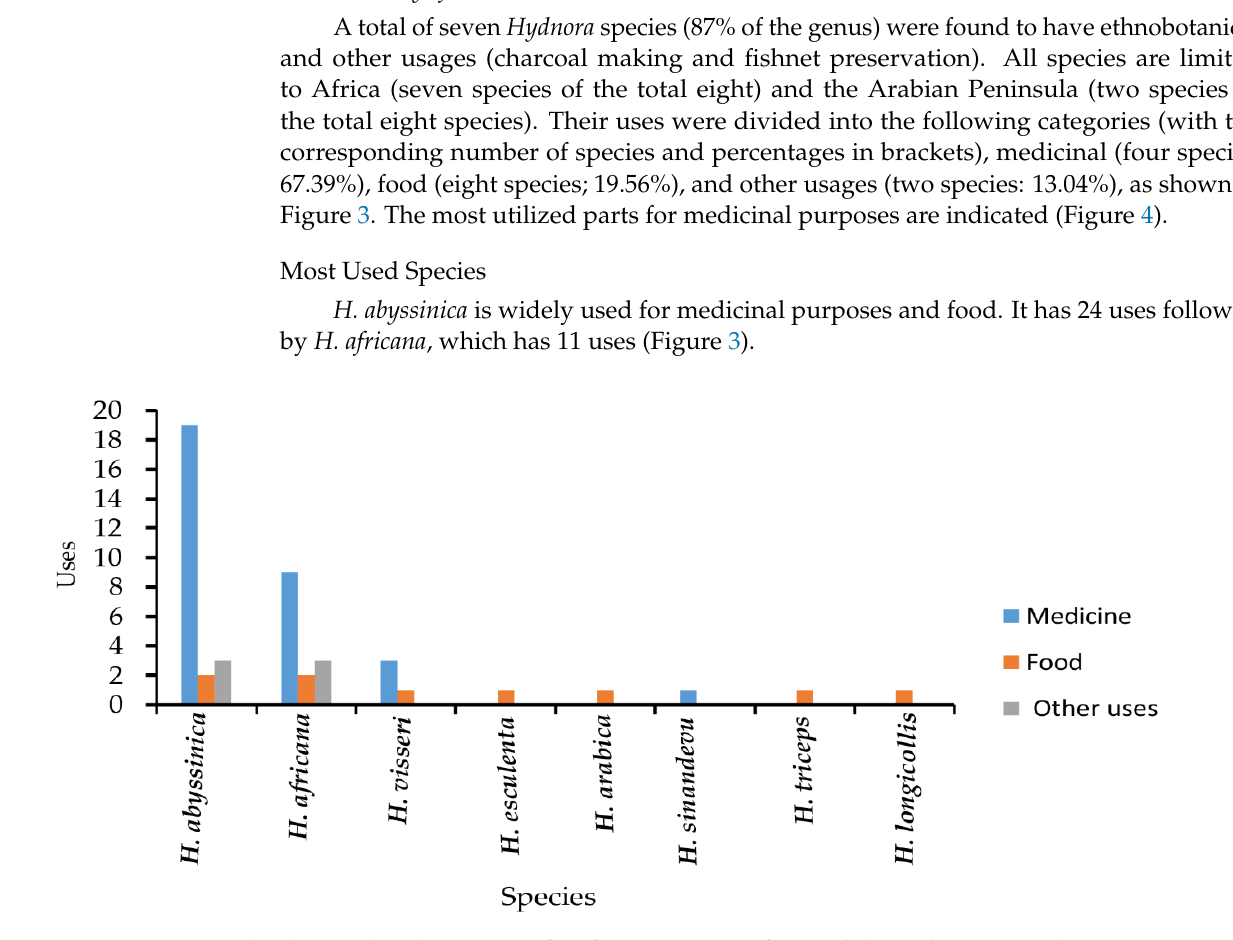
Figure 3. Ethnobotanical and other uses of Hydnora species in Africa and the Arabian Peninsula.